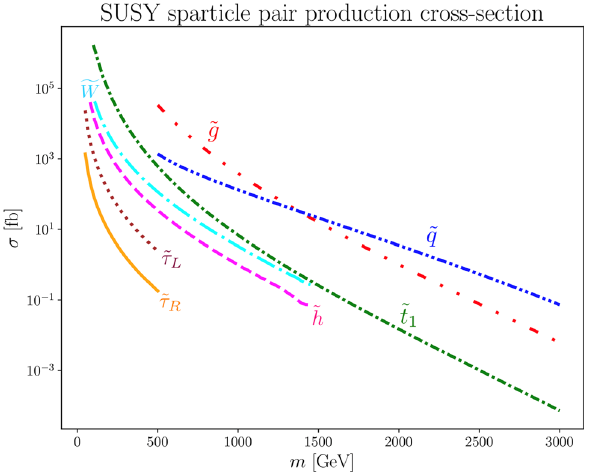
Fig. 1 Upper panel: the production cross-sections for various spar- ticle species. For the coloured particles ( ˜ g , ˜ q and ˜ t 1 ), we show NNLO Approx +NNLL cross-sections [71], while the cross-sections plot- ted for the weakly-interacting particles ( (cid:7) W , ˜ h and ˜ τ L / R ) are calculated to NLO+NLL accuracy [72]. Lower panel: the velocity distributions for various sparticle species. The following representative masses were chosen: ˜ g : 1010 GeV, ˜ q : 920 GeV, ˜ t 1 : 720 GeV, (cid:7) W : 300 GeV, ˜ τ L : 80 GeV